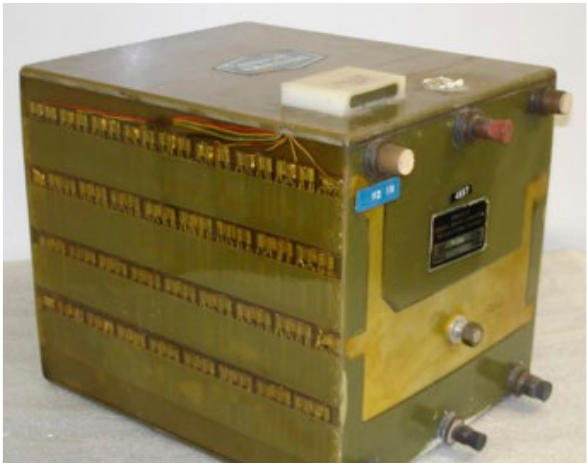
Figure 7. Sample Union Carbide KOH fuel cell for General Motors “Electrovan.” NMAH catalog no. 2007.3061.01. Smithsonian